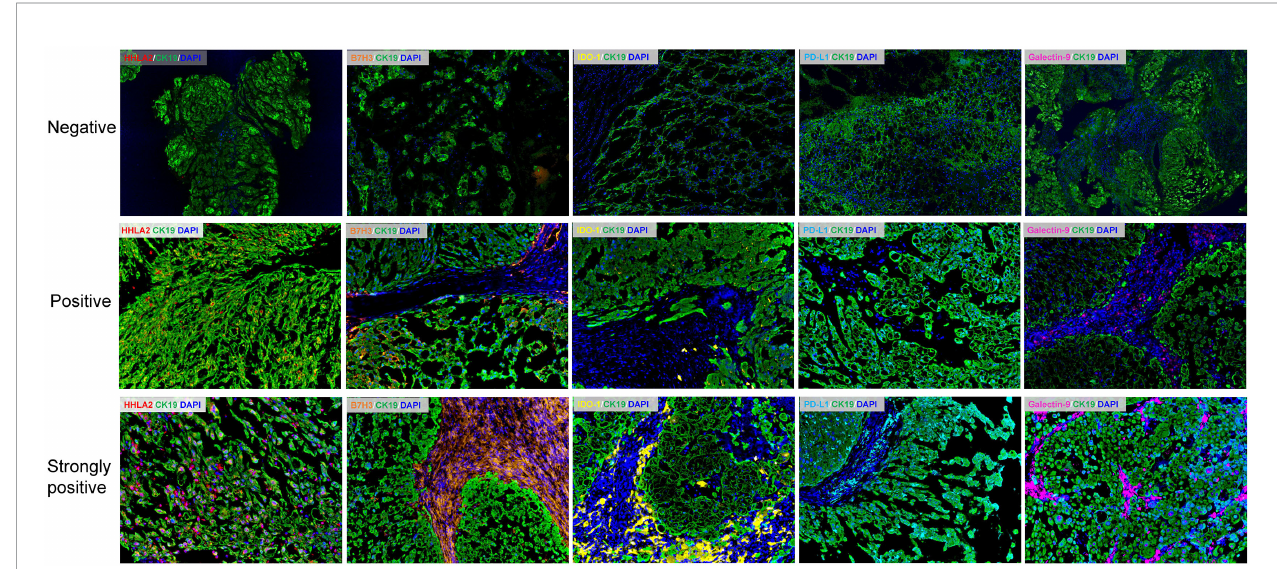
FIGURE 3 | Representative immuno fl uorescence images showing negative, positive and strongly positive expression of HHLA2, B7H3, IDO-1, PD-L1 and Galectin-9 within the tumor and stromal subregions of chordoma tissues. Scale bar = 100 m m. Nuclei were stained with DAPI.